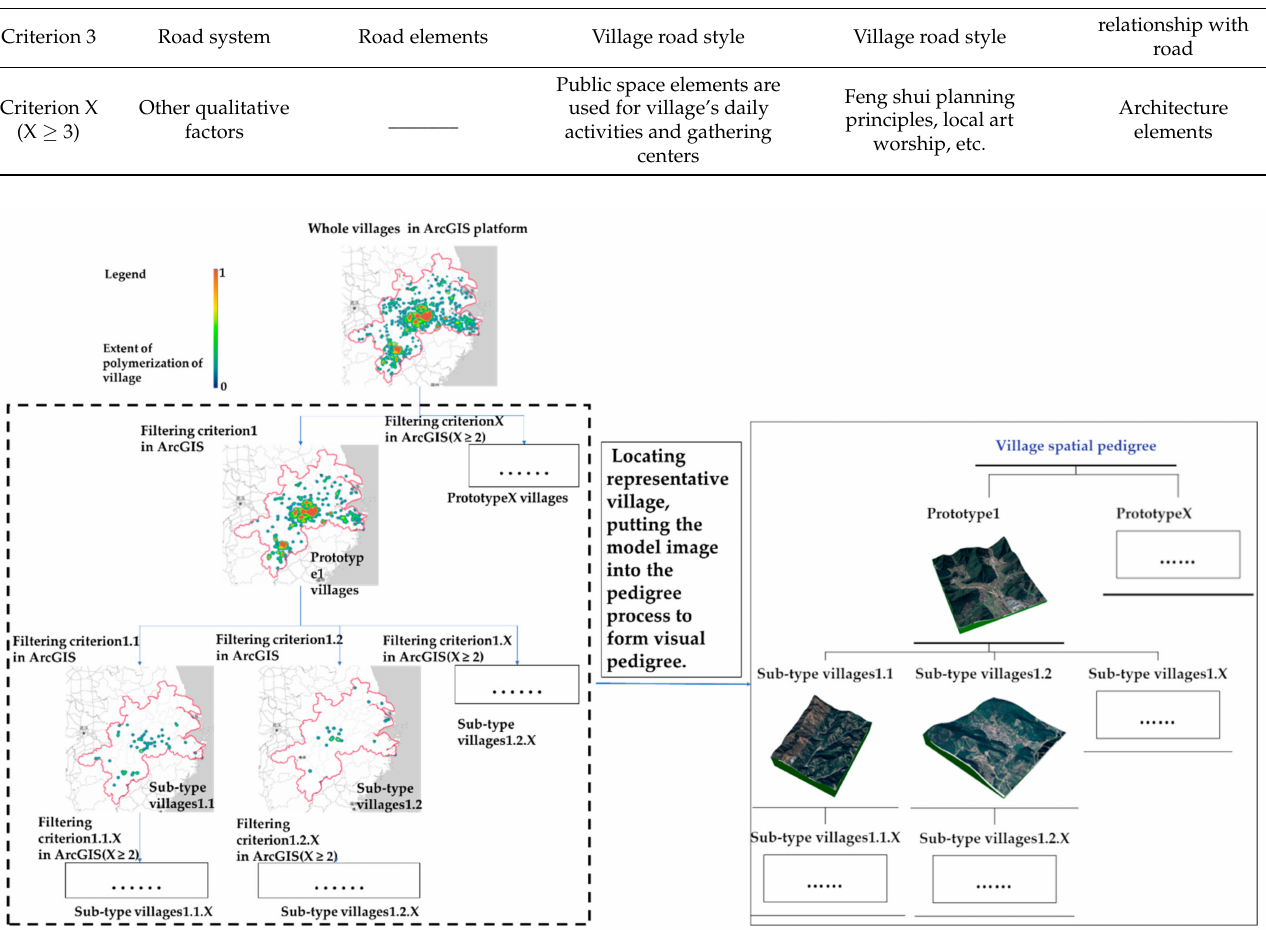
Figure 5. The process to filter the villages and visualize